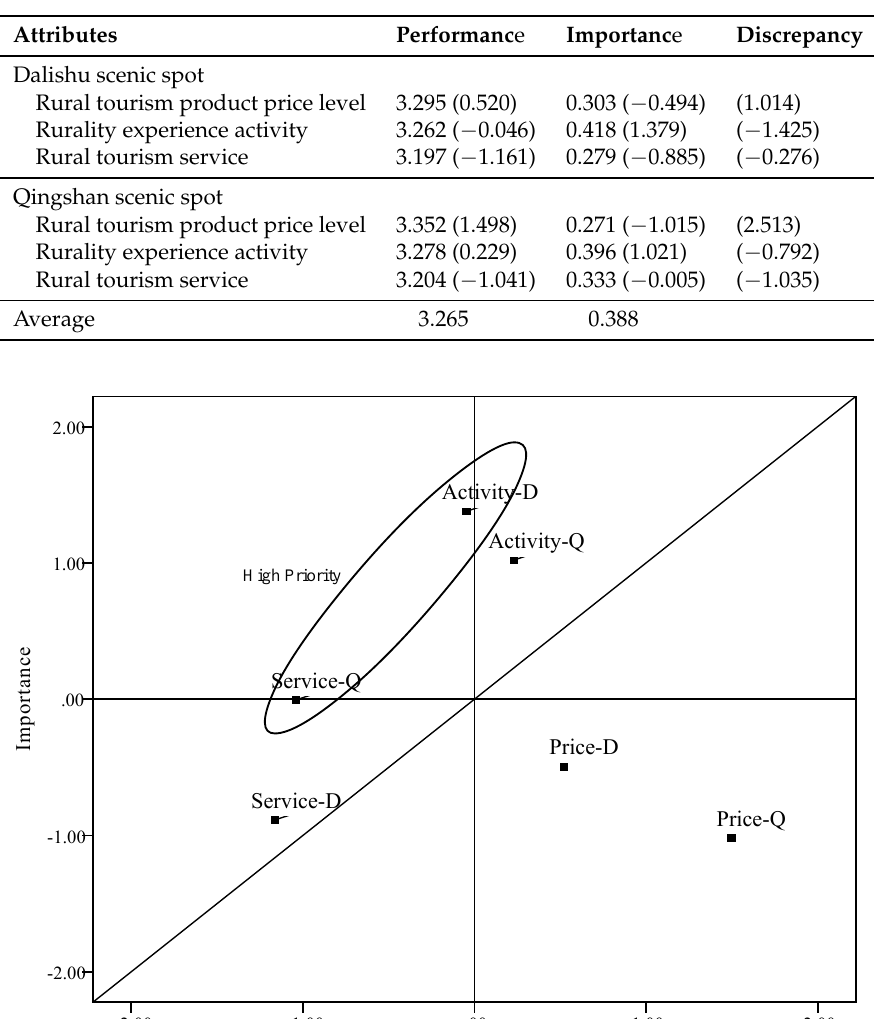
Table 6. Importance and performance of rural tourism products attributes.